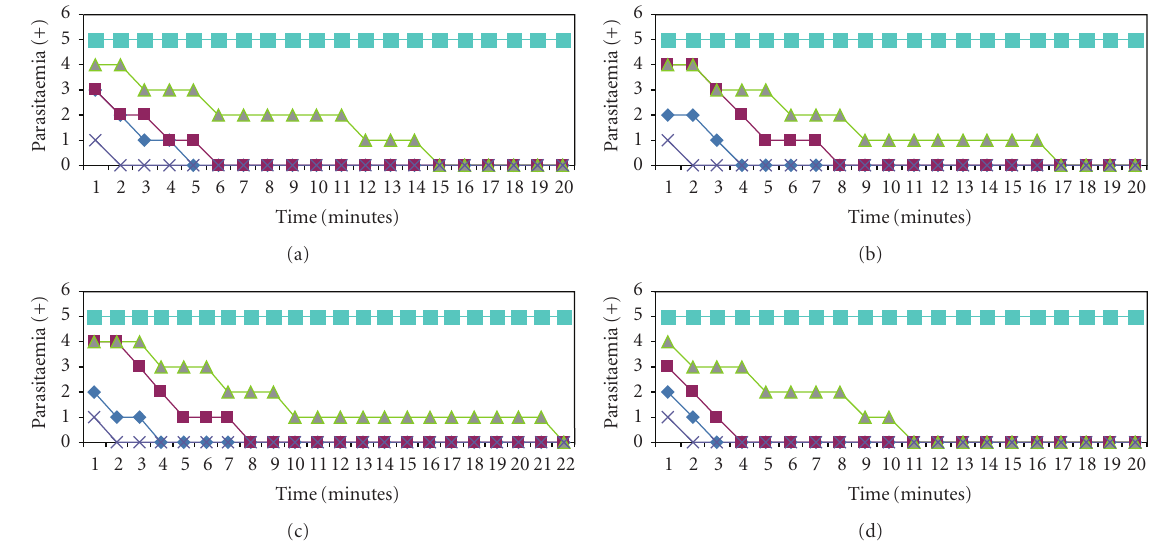
Figure 2: E ff ect of CS (a), ED (b), EC (c) and CC (d) essential oils (EO) on Tbb blood forms. The EOs were diluted at 0.4 g/mL (dark blue), 0.2g/mL (red) or 0.1g/mL (green) in pure vegetable oil as diluent and then added to the cultures, as described previously. Treatment of the parasites with Diminaveto (Positive control, purple) induced total lysis after 2 minutes. The number of parasites remained constant in negative controls and diluent control (light